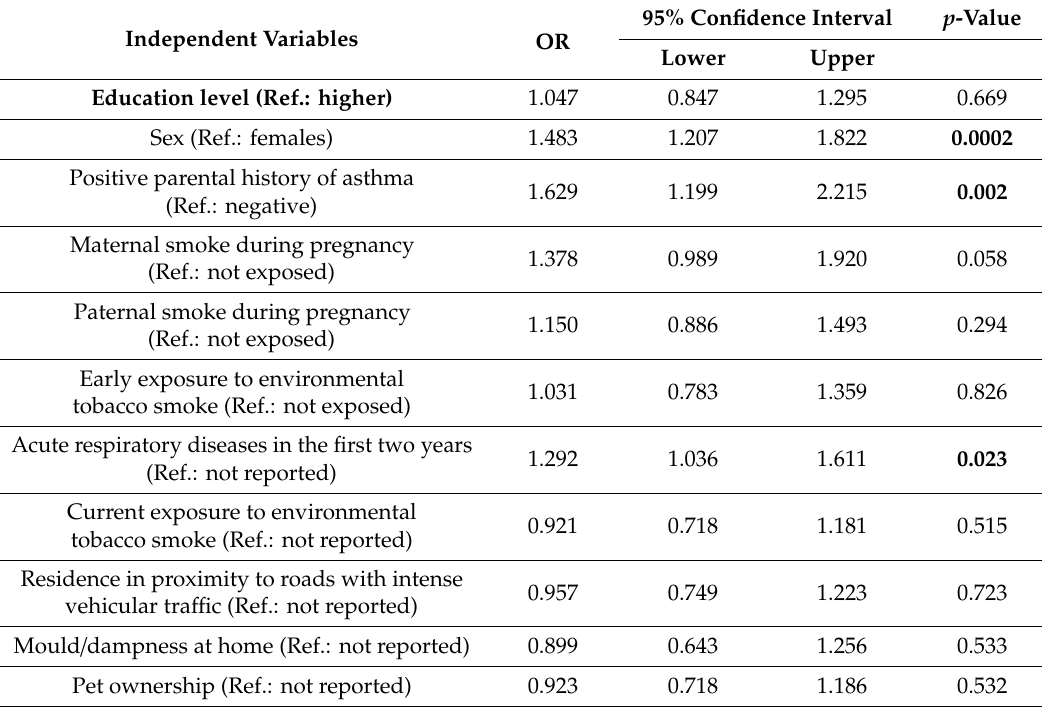
Table 4. Multiple logistic association model for allergic sensitization in the overall study population ( n = 1714). OR: Odds Ratio. Significant p -Values are in